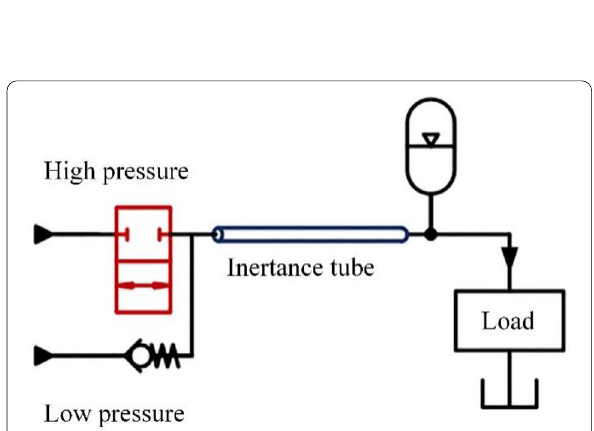
Figure 31 Separate meter-in and separate meter-out control system developed by Linjama et al.